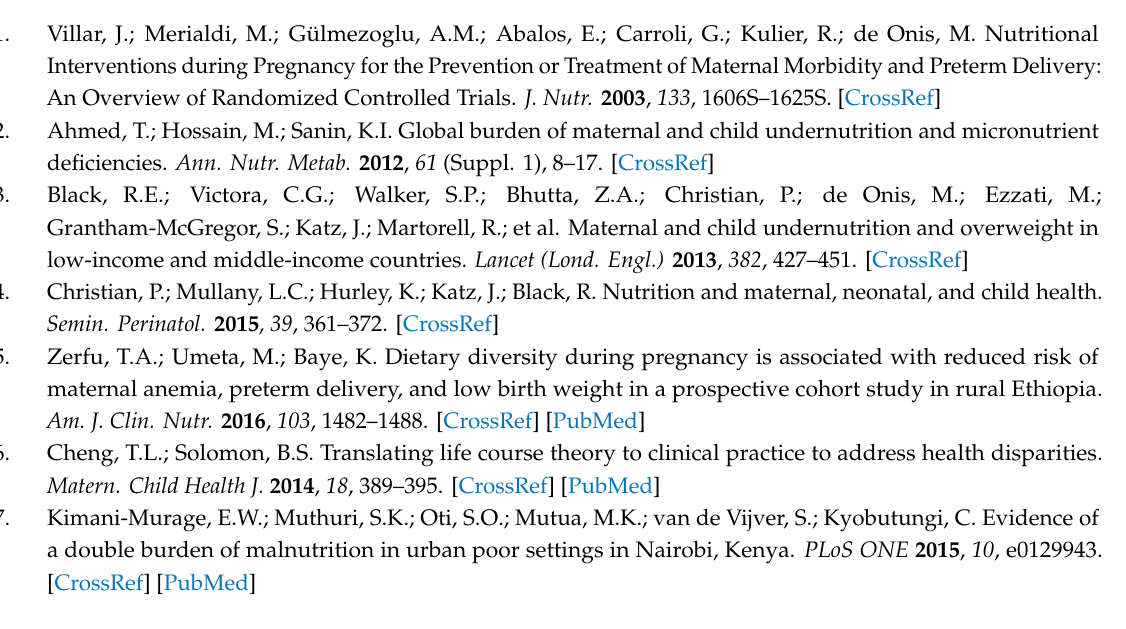
Figure S1: Search Flow Diagram, Figure S2: Risk of Bias Summary, Figure S3: Forest plot of comparison: Balanced Energy Protein vs. Control, outcome: Stillbirth, Figure S4: Forest plot of comparison: Food Program vs. Control, outcome: Perinatal Mortality; Table S1: Search Strategies, Table S2: Quality of evidence, as determined by GRADE criteria, Table S3: Characteristics of Included Studies, Table S4: Summary of Meta-Analysis, Table S5: Summary of Findings (SoF) Table of Balanced Energy Protein (BEP), Table S6: Summary of Findings of Food Distribution Program